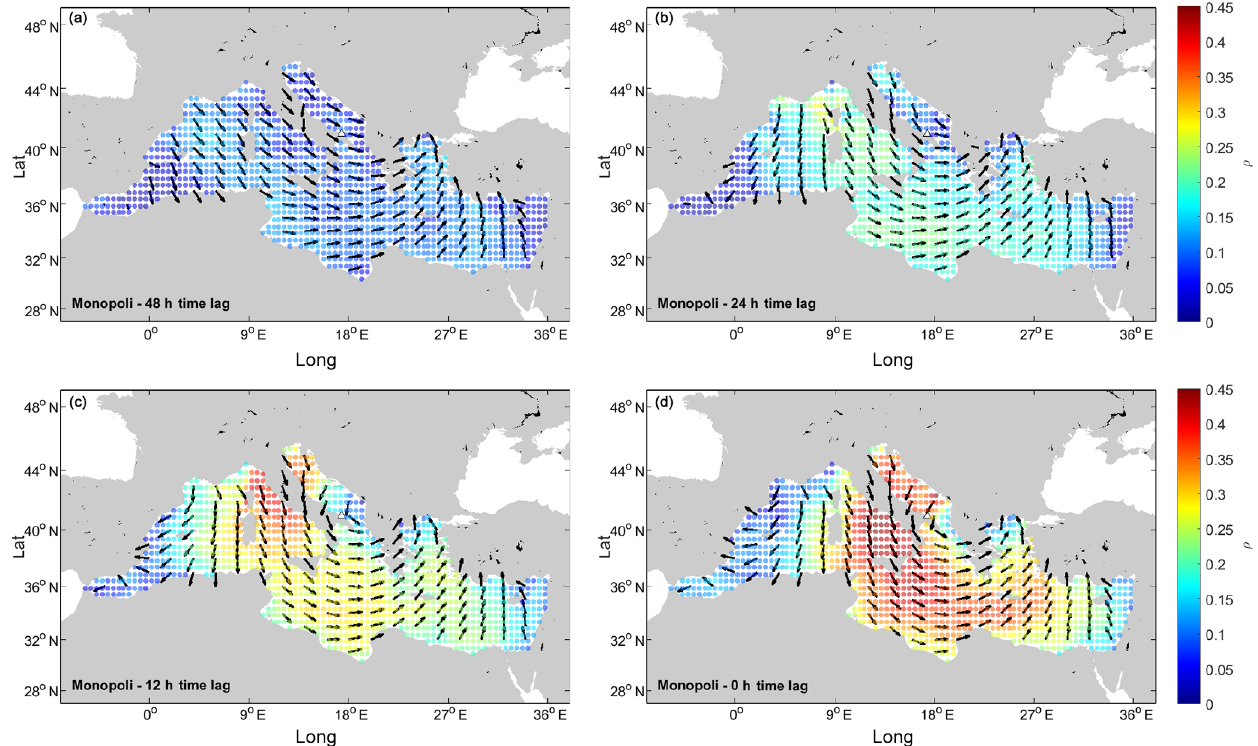
Figure 2. Correlations between H s and u w in location B4 for different time lags. (a) (cid:49)t equals 48h; (b) (cid:49)t equals 24h; (c) (cid:49)t equals 12h; and (d) (cid:49)t equals